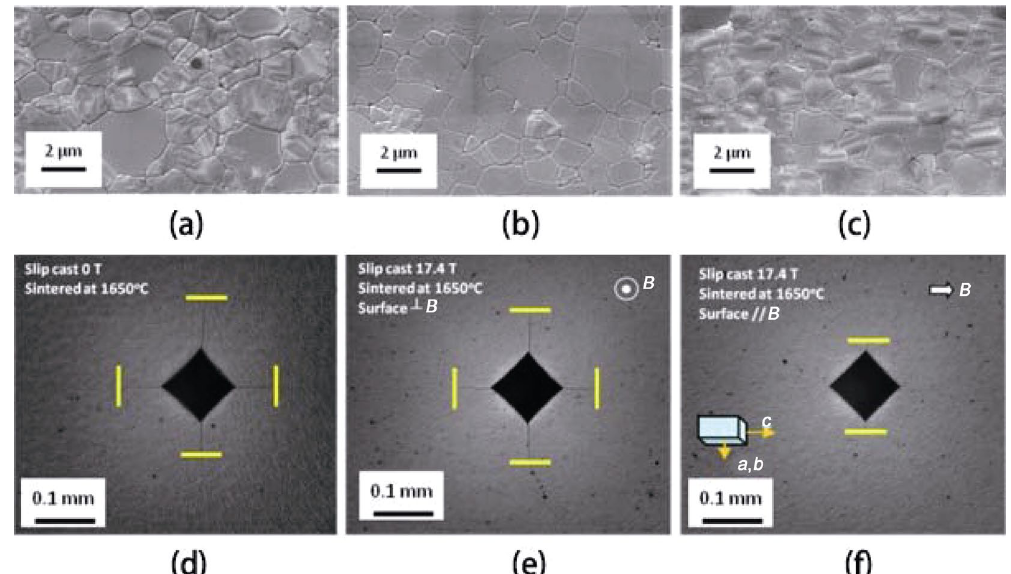
Fig. 39 Microstructure and 10 kg Vickers indentations of untextured and textured zirconia specimens: (a, d) untextured specimen; (b, c, e, f) textured specimen surfaces perpendicular (b, e) and parallel (c, f) to the magnetic field, respectively. Reproduced with permission from Ref. [100], © Elsevier Ltd. 2015.